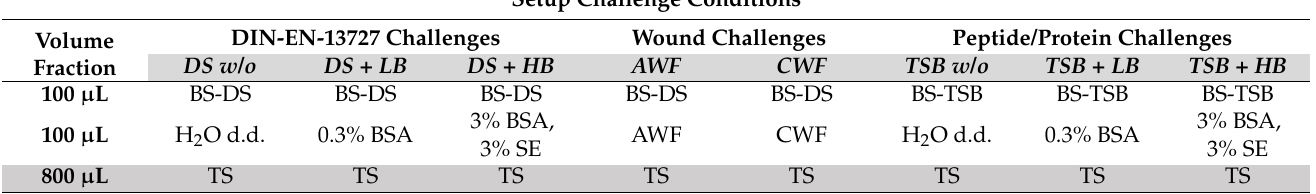
Table 3. Experimental challenge conditions in the quantitative suspension method (QSM). Compo- sition of the experimental setups in the quantitative suspension method using different challenge substances and bacterial suspensions to which the test solution (antimicrobial/antiseptic agent) is